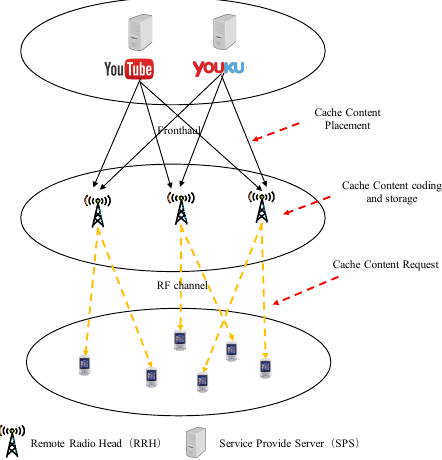
Figure 1. System Architecture of CMM-CRAN.